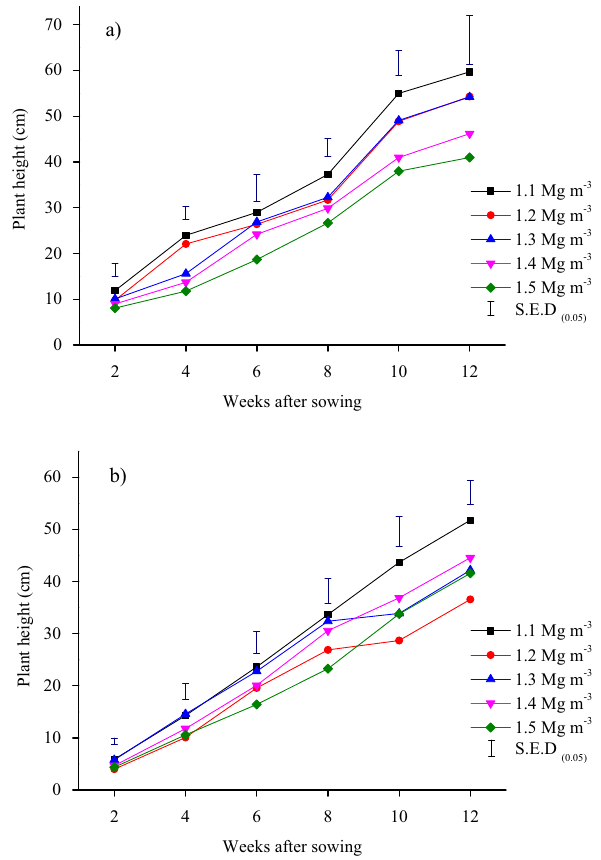
Figure 2: E ff ect of soil compaction on groundnut plant height in: ( a ) year 1 and ( b ) year